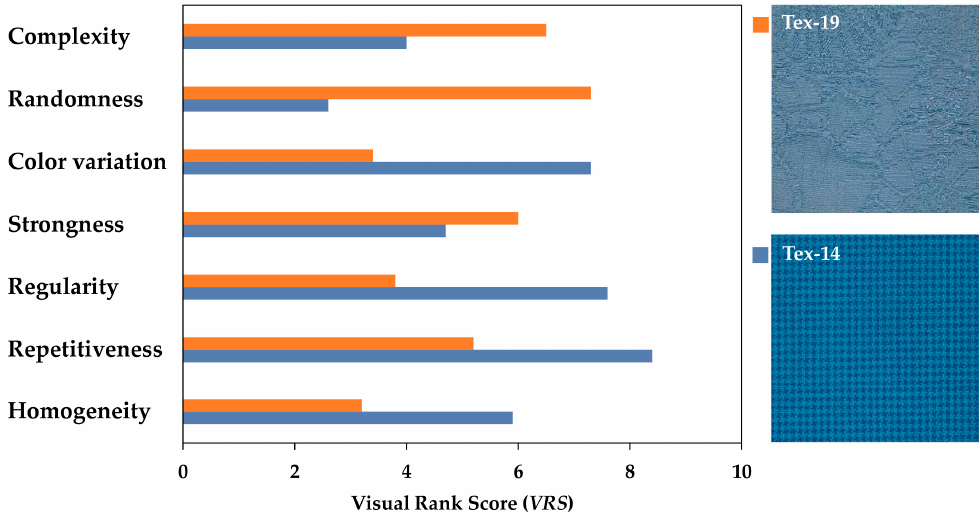
Figure 6. The visual rank scores ( VRS ) of Tex-19 and Tex-14 for the various texture attributes. For instance, Tex-19 had higher complexity , randomness and strongness , while Tex-14 had higher color variation , regularity , repetitiveness , and homogeneity .